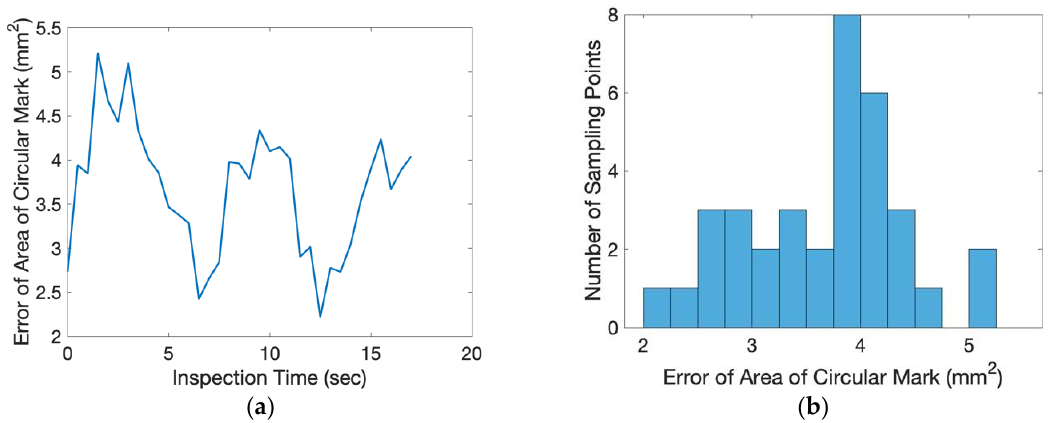
Figure 14. Error of the measured circular area during the inspection process: ( a ) analysis with respect to time, ( b ) histogram of analysis. Table 2. Experimental results of the presented process of inline inspection with an industrial robot (IIIR).